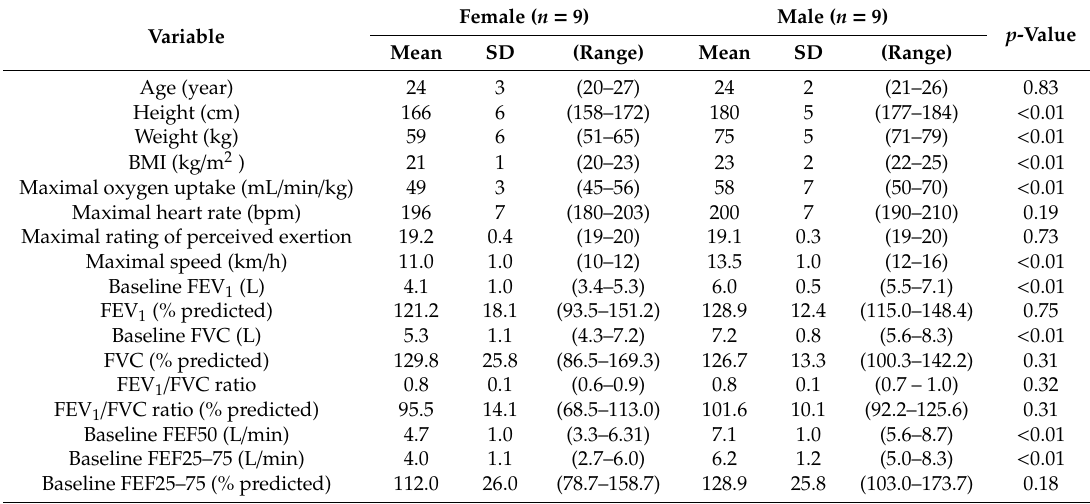
Table 1. Descriptive anthropometric, graded exercise test and baseline respiratory